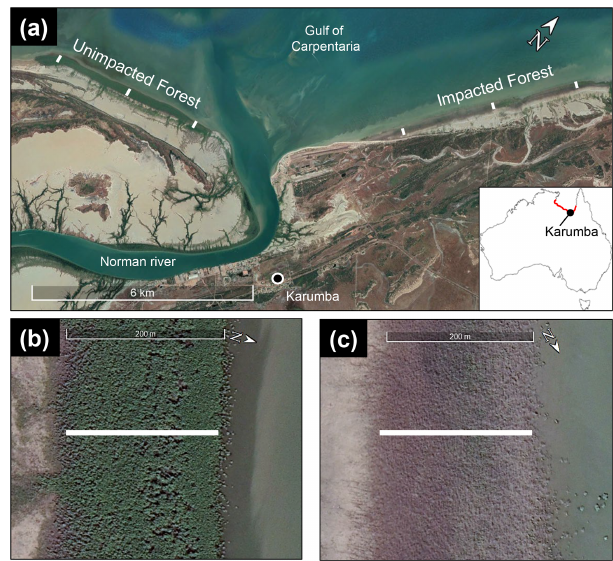
Figure 1. The study location at Karumba in the Gulf of Carpentaria, Queensland, Australia ( − 17 . 435572 ◦ S, 140.844766 ◦ E; image pro- vided by ©Google Earth). (a) Three sampling transects within the unimpacted reference site and three within the impacted site (shown as a white line). (b, c) Representative transects from the unim- pacted (b) and impacted (c) sites. Each transect was approximately 200m. Samples were collected along each transect from higher to lower intertidal zones. Red indicated mass dieback